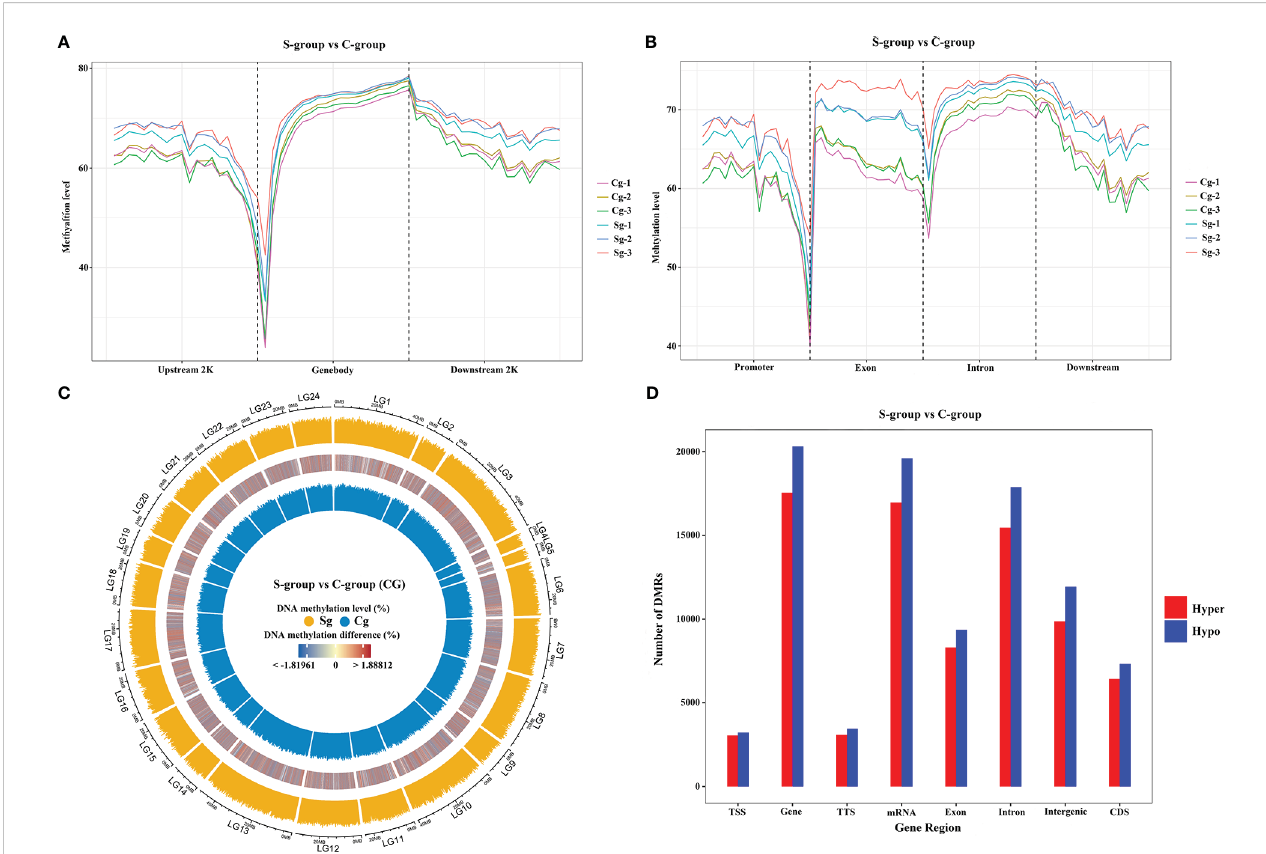
FIGURE 5 Comparative methylome analysis in the gills of large yellow croaker under low-salinity stress. (A) Density plot of methylation levels in different regions of up-stream, gene body, and down-stream regions. (B) Density plot of methylation levels on different functional genomic elements. (C) Circos plot of CG- type methylation levels between S-group and C-group, the outer circle represents the S-group, the inner circle represents the C-group, and the middle circle is the differential methylation levels between the two groups; LG1 – 24 indicated large yellow croaker chromosome (NC_040011.1, NC_040012.1, NC_040013.1, NC_040014.1, NC_040015.1, NC_040016.1, NC_040017.1, NC_040018.1, NC_040019.1, NC_040020.1, NC_040021.1, NC_040022.1, NC_040023.1, NC_040024.1, NC_040025.1, NC_040026.1, NC_040027.1, NC_040028.1, NC_040029.1, NC_040030.1, NC_040031.1, NC_040032.1, NC_040033.1, NC_040034.1) (D) Distribution of hypo-methylated and hyper-methylated DMR numbers between the S-group and C-group in different functional genomic